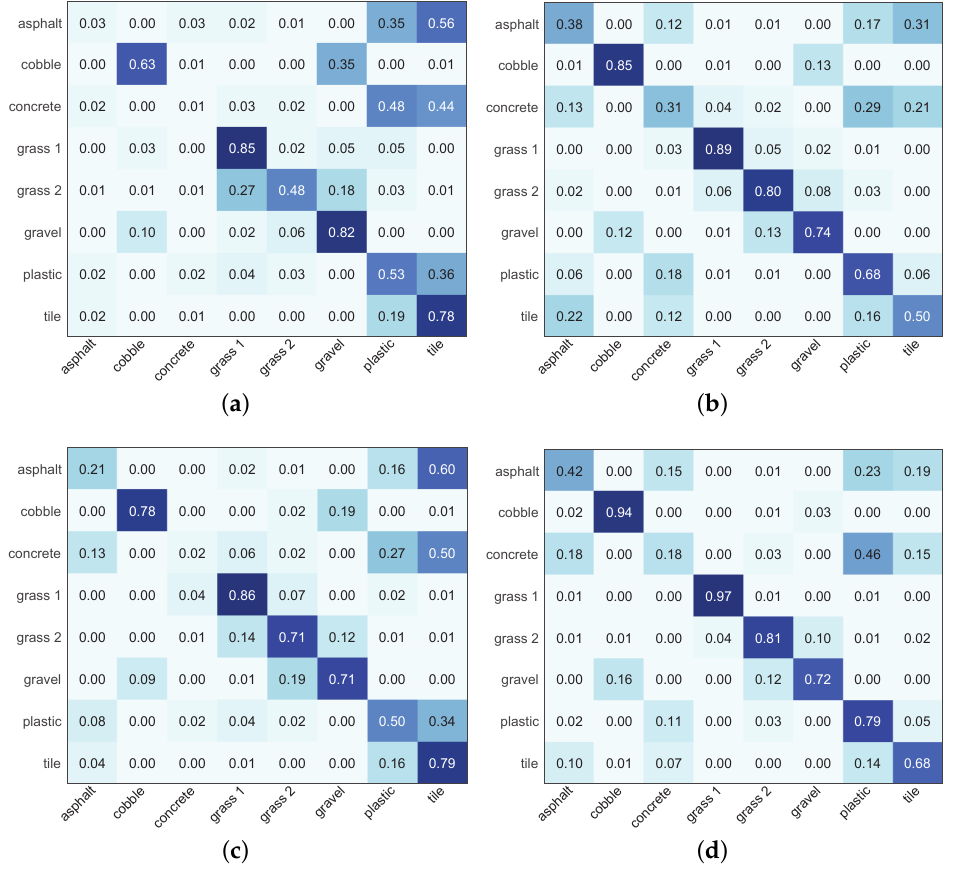
Figure 7. Normalized confusion matrices of ( a ) T-NB, ( b ) T-RF, ( c ) PSD-NB, ( d )